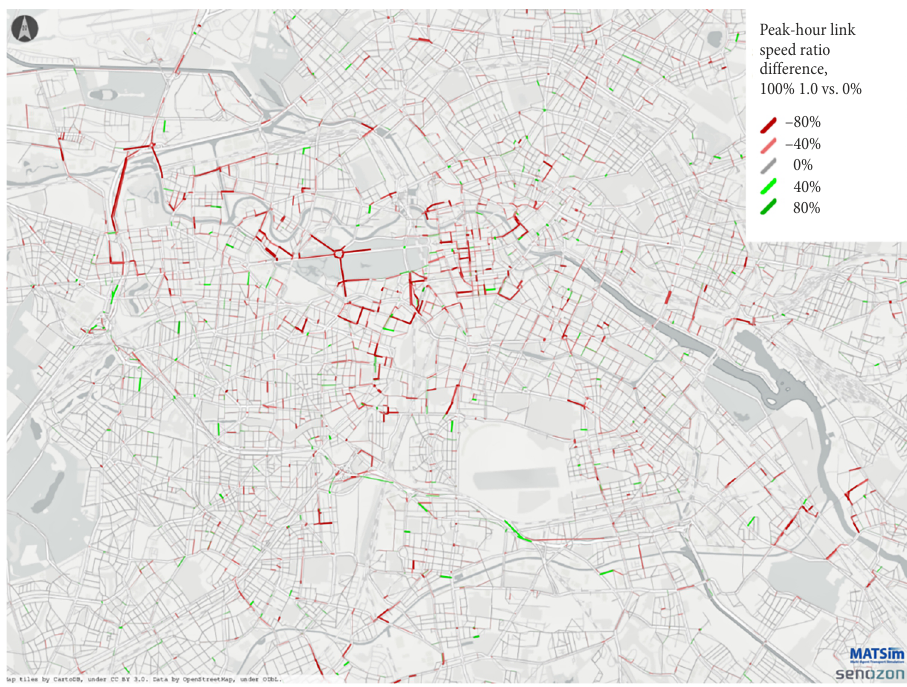
Figure 5. Differences in the link speed ratios on links during the pm peak hour between the full replacement with no AV flow improvement (100%, 1.0) case and the no AT (0%) case (additional empty rides result in an overall decrease of network speed, marked in